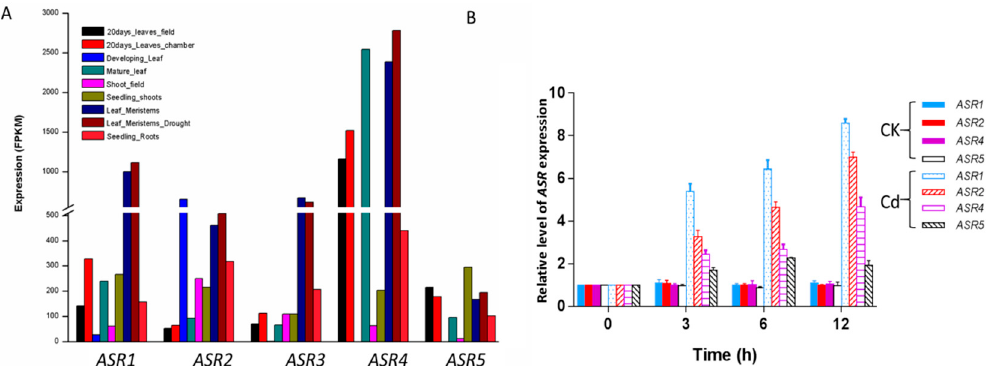
Figure 2. Expression patterns of maize ZmASR genes. ( A ) In silico analysis of the expression of maize ZmASR genes in different tissues. Maize transcript profiles were retrieved from five transcriptomic studies (Supplementary Table S1) hosted in qTeller (http://qteller.com). Gene expression values were represented by FPKM. ( B ) Expression analysis of ASRs in leaves of maize plants exposed to Cd treatment. Maize plants were treated with Cd(NO 3 ) 2 for various times as indicated. The relative expression levels of genes was analyzed by real-time qRT-PCR. Values are means ± SE of three independent experiments.